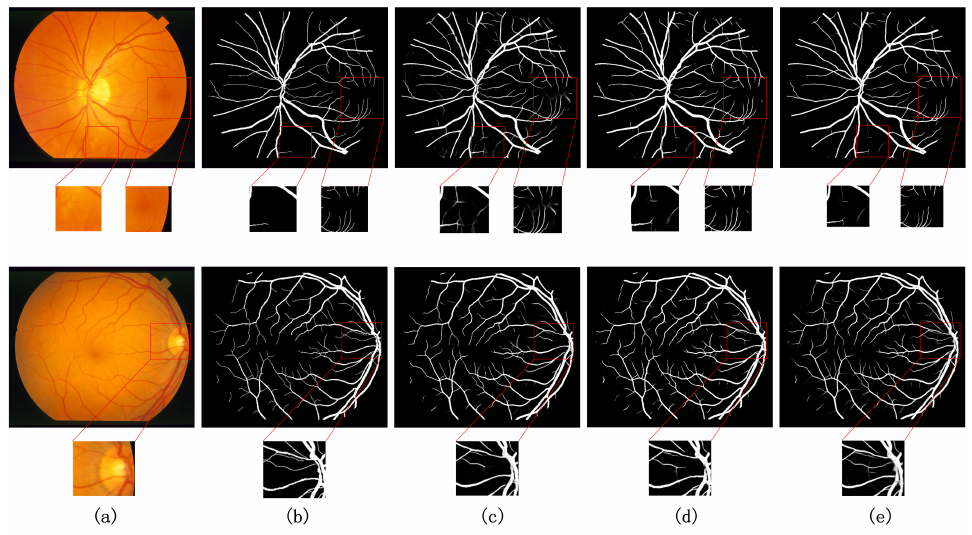
Figure 11. Comparison of visualization results with other methods on STARE dataset ( a ) original image, ( b ) groundtruth image, ( c ) UNet++ [13], ( d ) CA-Net [13], ( e ) Ours.